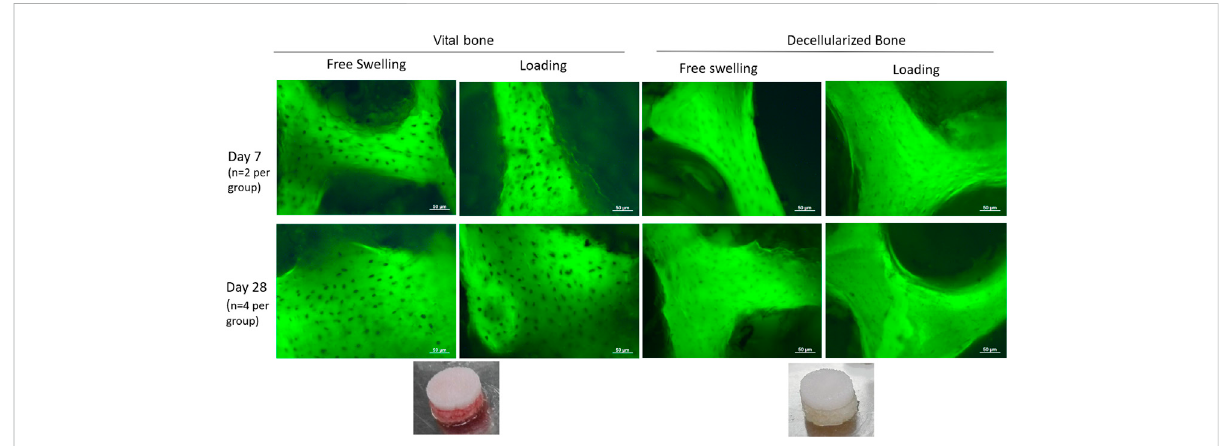
FIGURE 6 LDHstainingofviableosteocyteswithinculturedboneexplants.Darkspotsindicateaviableosteocytevisibleagainsttheauto fl uorescentbone. Osteocytes in viable bone remained viable for up to 28 days, while the decellularization process was successful at removing all viable osteocytes.